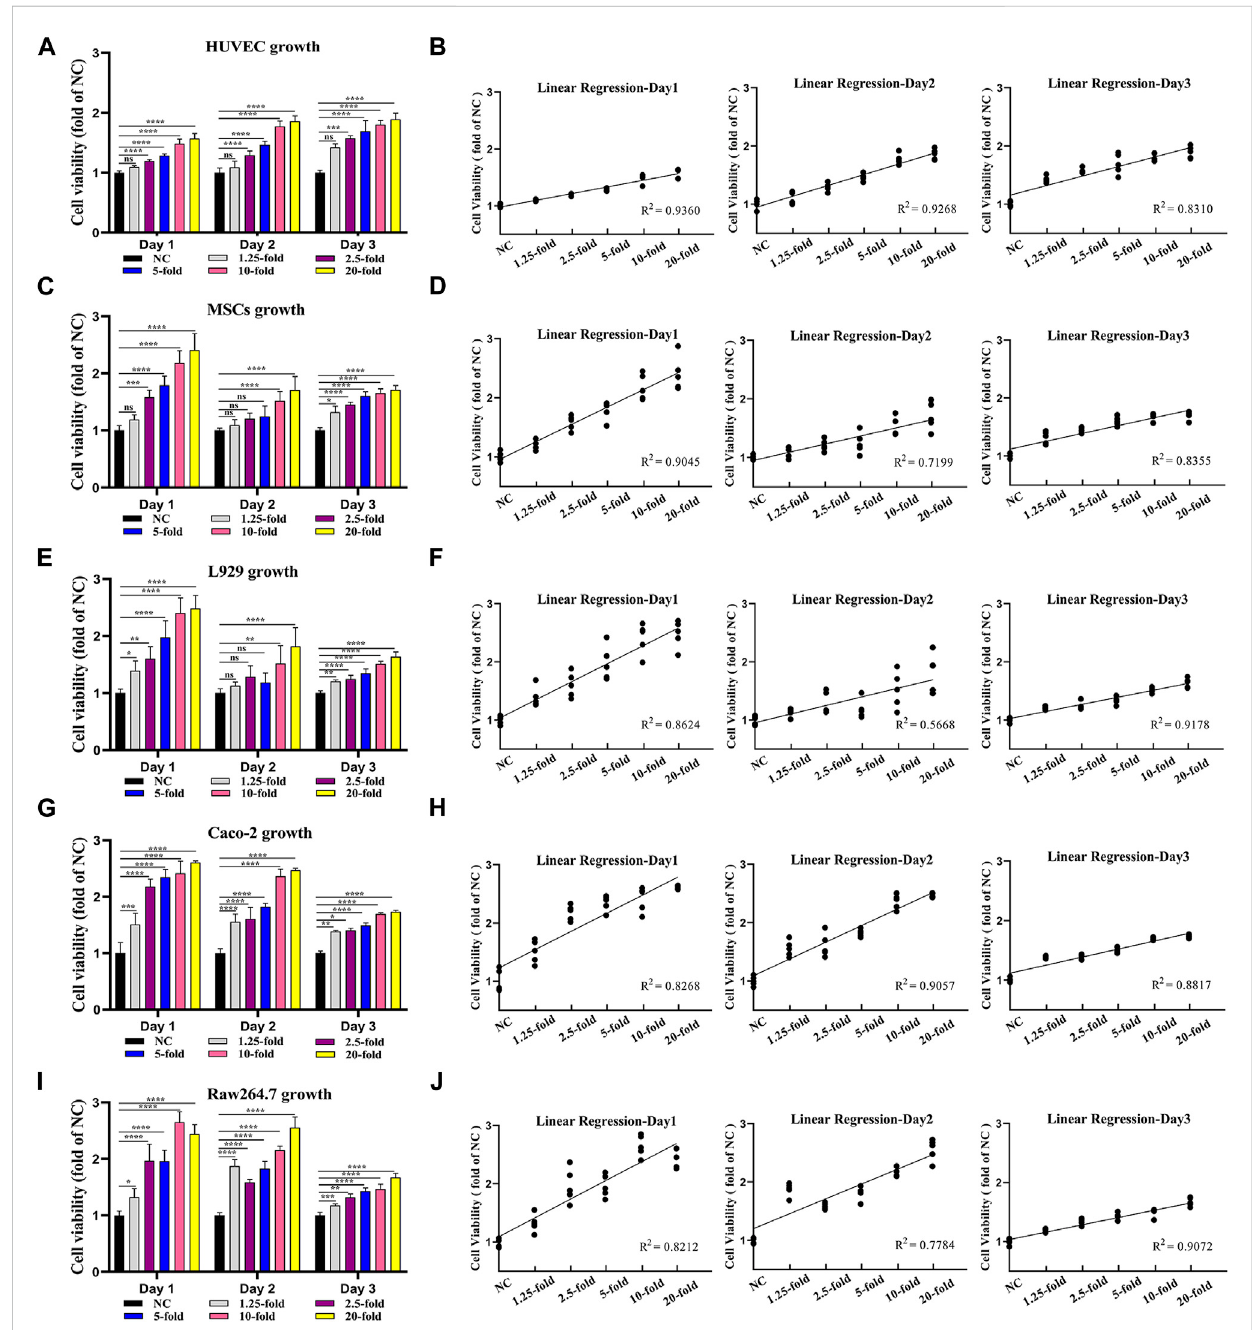
FIGURE 2 MSCs secretome enhances the viability of key cells for tissue healing in a dose-dependent manner. Vascular endothelial cells (HUVEC) (A) , mesenchymal stem cells (MSCs) (C) , fi broblasts (L929) (E) , intestinal epithelial cells (Caco-2) (G) , and macrophages (Raw264.7) (I) are treated with various MSCs secretome concentrations (1.25-, 2.5-, 5-, 10-, and 20-fold), and cell viability is measured using the CCK-8 assay on day 1, day 2, and day 3. The linear regression relation between MSCs secretome concentration and cell viability, including HUVEC (B) , MSCs (D) , L929 (F) , Caco-2 (H) , and Raw264.7 (J) ( n = 5 per group; ANOVA). **** p < 0.0001, *** p < 0.001, ** p < 0.01, * p < 0.05, ns ≥